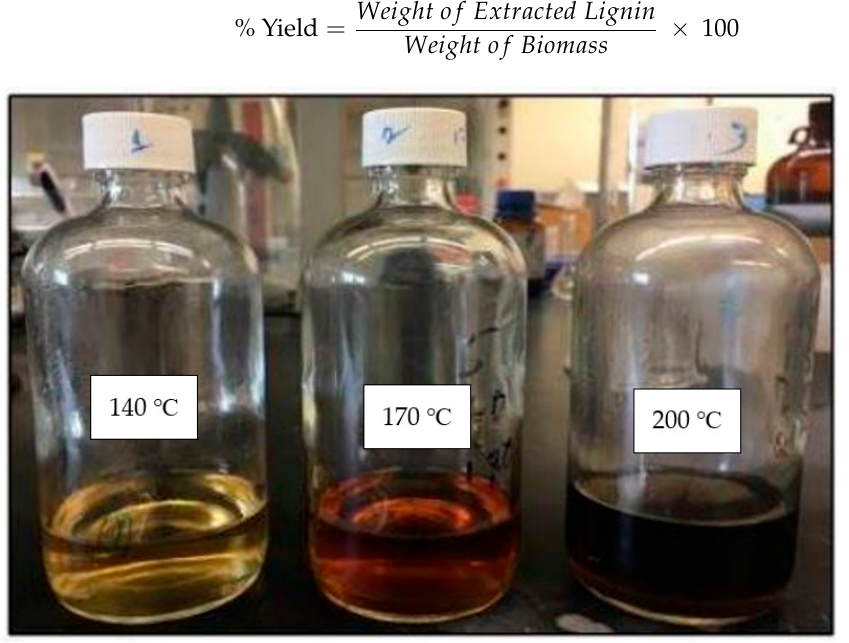
Figure 2. Extraction of lignin from the pine sawdust biomass at different temperatures.